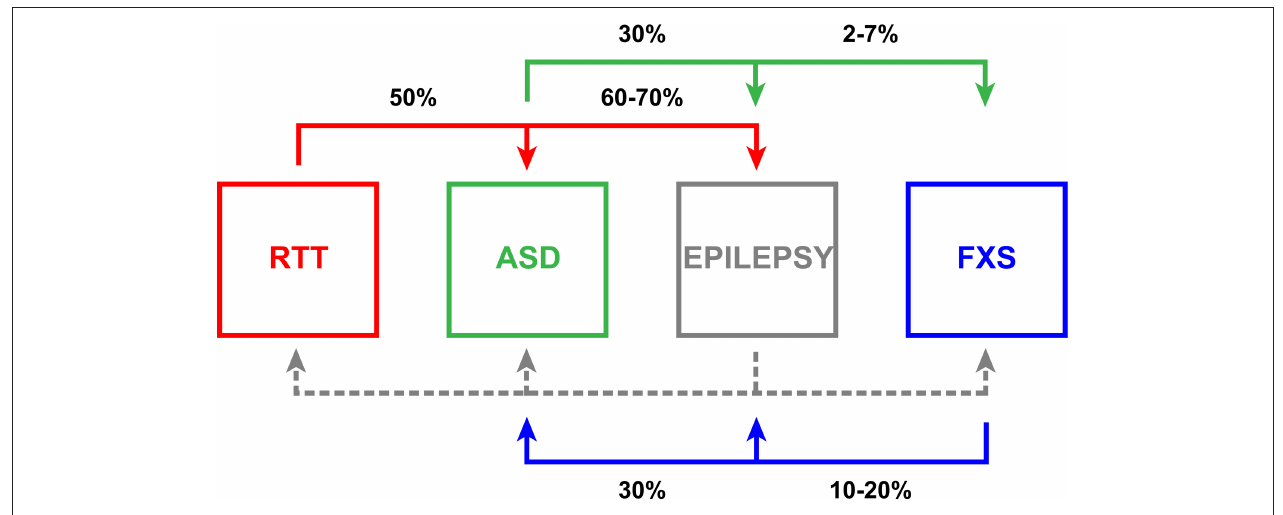
but comparable associative statistics (dashed gray line) are not well documented in the literature. The interconnectivity amongst these disorders emphasizes the clinical significance of E/I ratio disruption and suggests that this imbalance likely renders a higher susceptibility to further